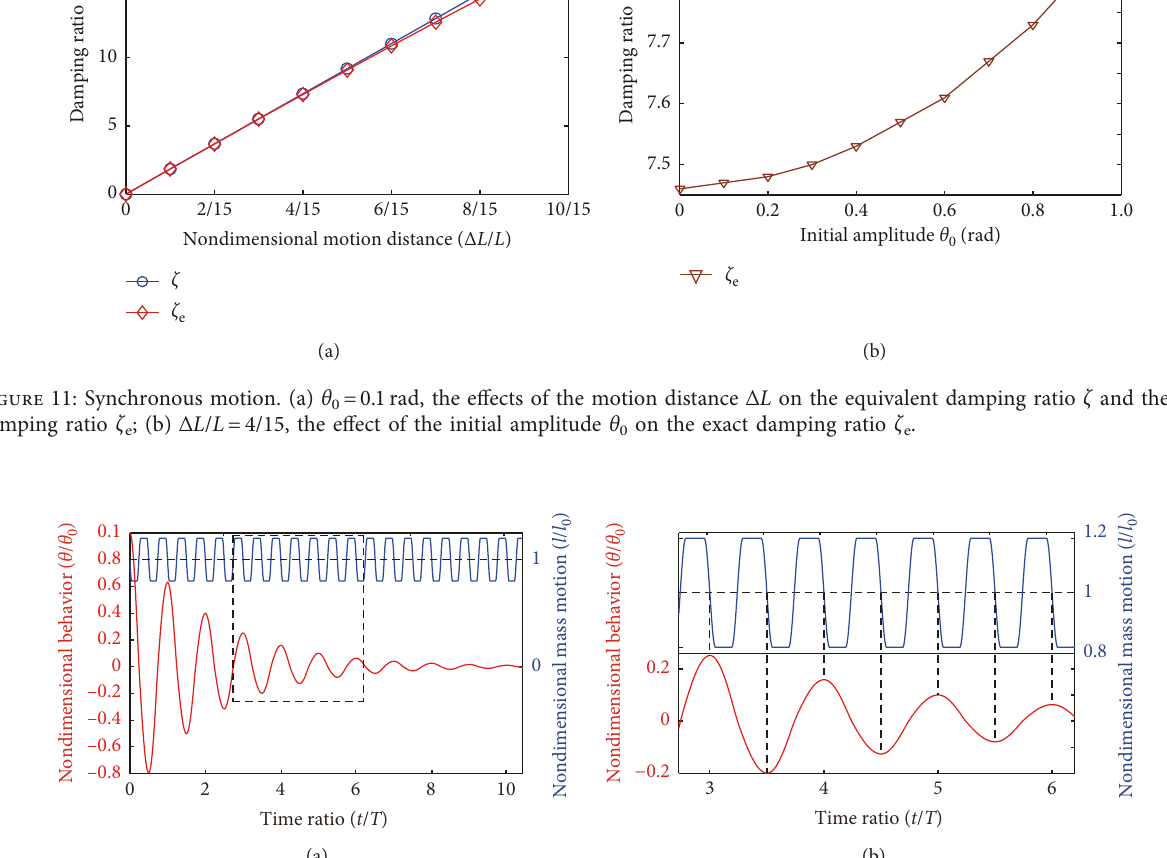
Figure 12: Synchronous motion. (a) The continuous pendulum behavior θ and the mass motion l ; (b) the partial enlargement of